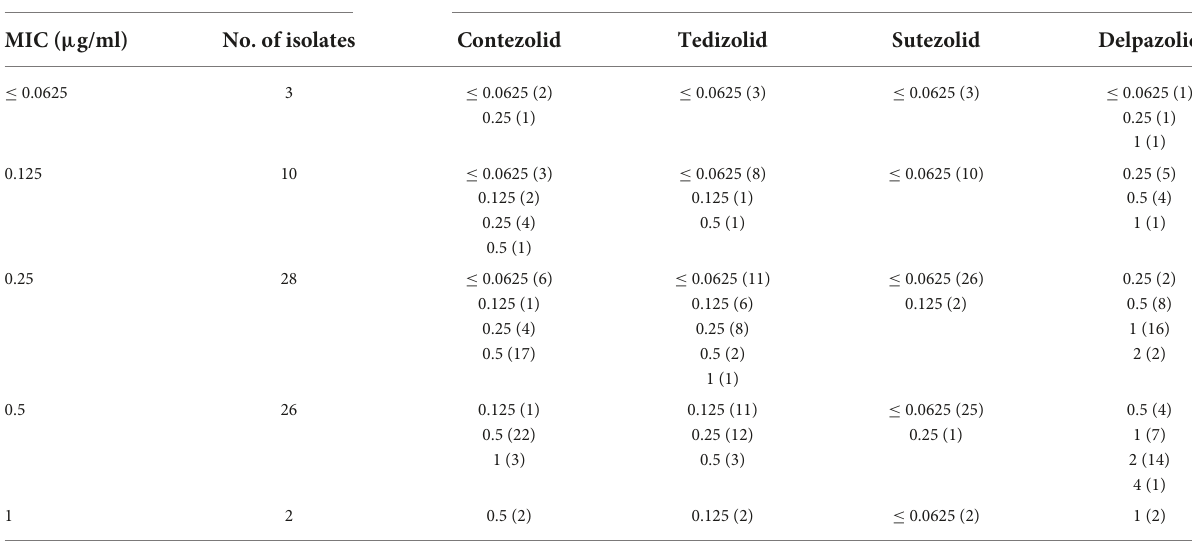
TABLE 3 MICs of the four novel oxazolidinones for the Mtb clinical isolates with different MICs of linezolid. Linezolid No. of isolates with different MICs ( µ